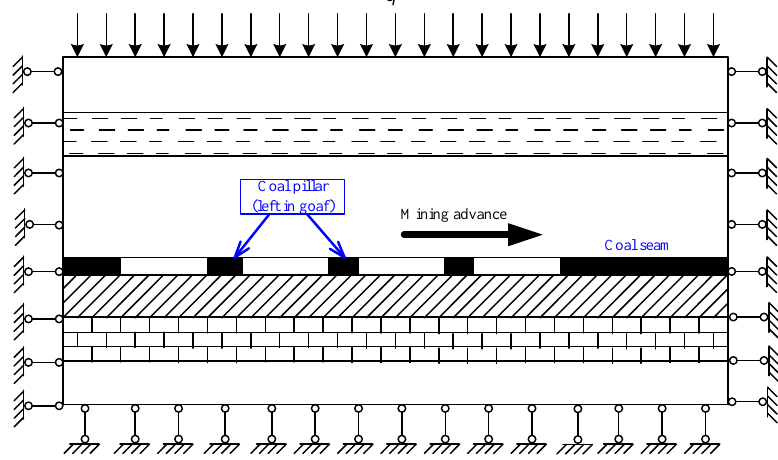
Figure 8. A mechanical model of coal seam longwall mining.